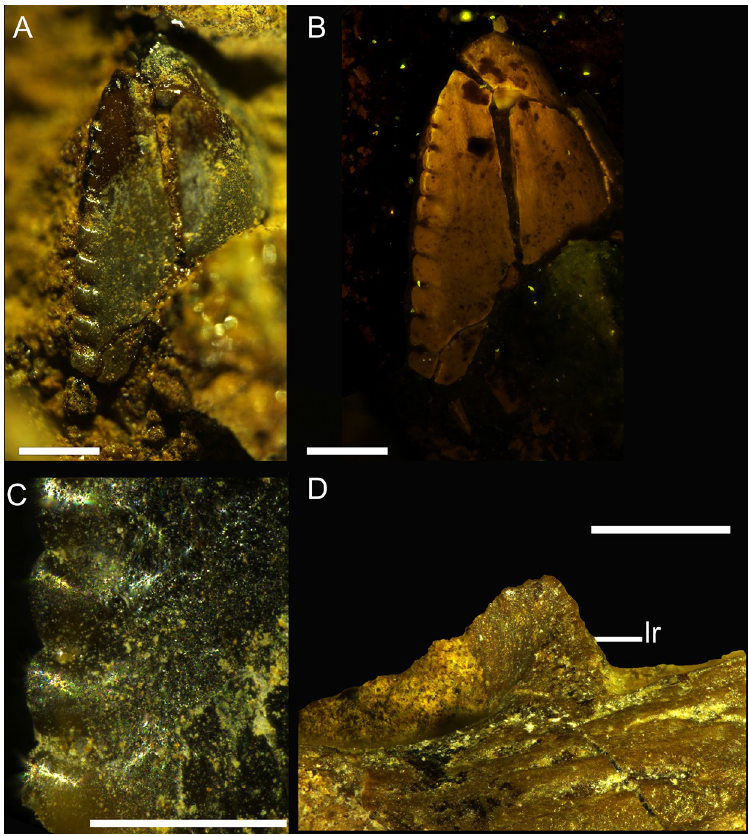
Fig 4. Closeup on the dentary teeth and lateral ridge in DMNH 21183. Detail of the 2 nd dentary tooth highlighting the distal carina under normal light (A) and fluorescent microscopy (B). Details of the distal denticles (C) and close-up of the lateral ridge (lr) close to the alveolar margin in lateral views (D). Abbreviation: lr, lateral ridge. Scale bar: 0.5